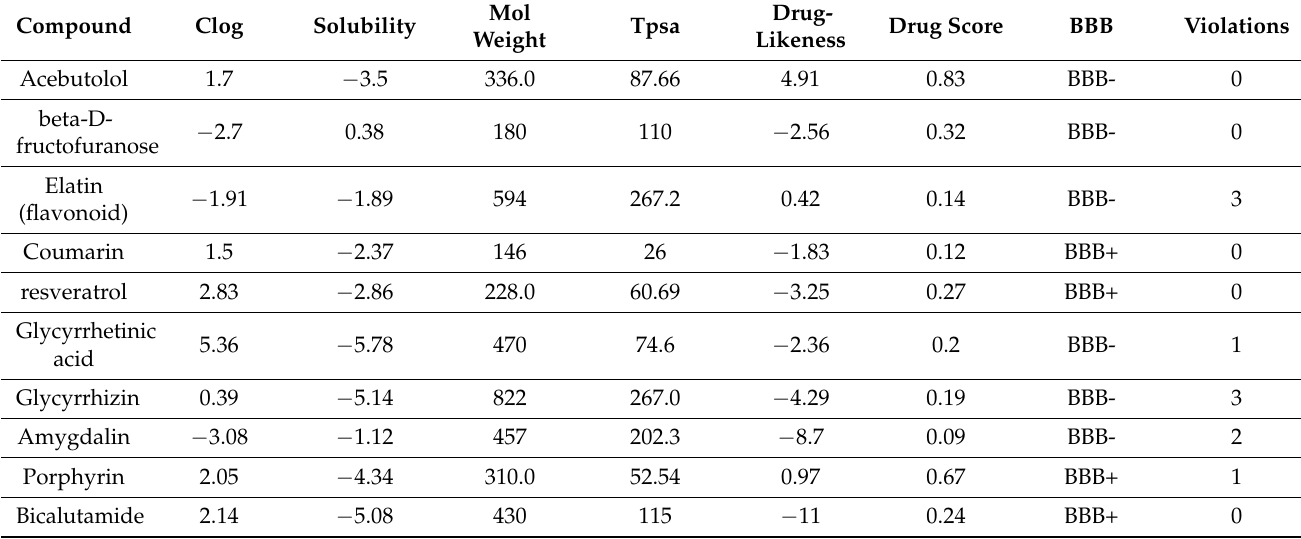
Table 6. Comparison of repurposed drugs based on their physical and chemical